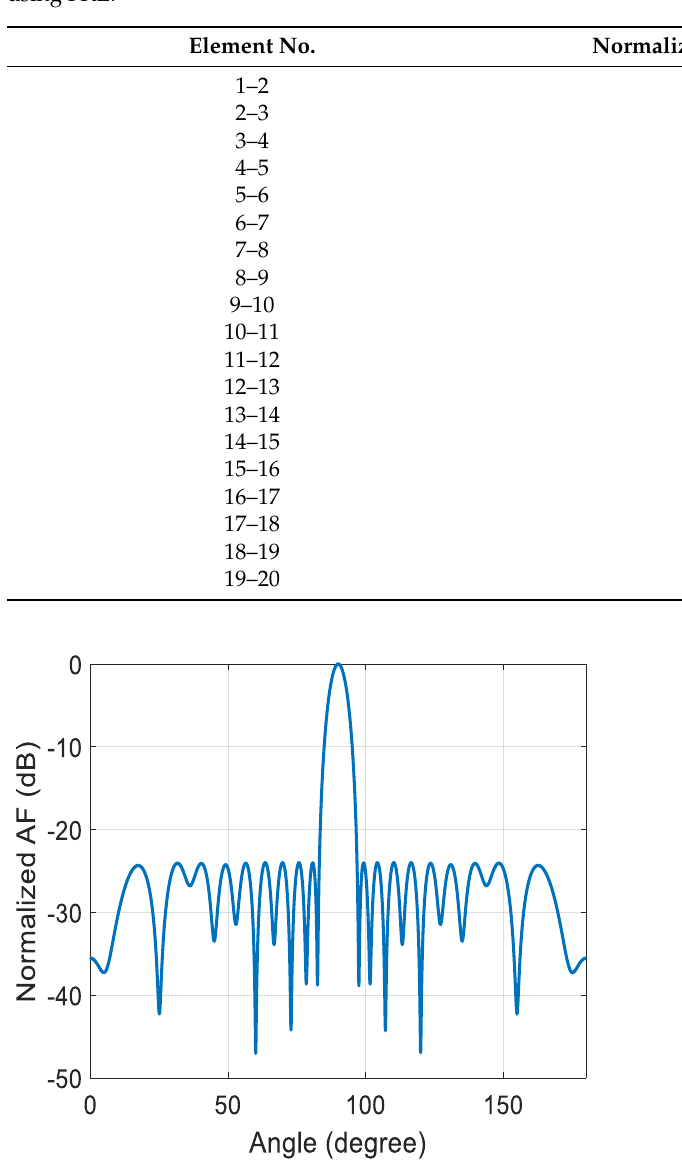
Figure 5. The normalized array factor for 20 element array antenna by optimizing the inter-element spacing of the array antenna using FKE algorithm.